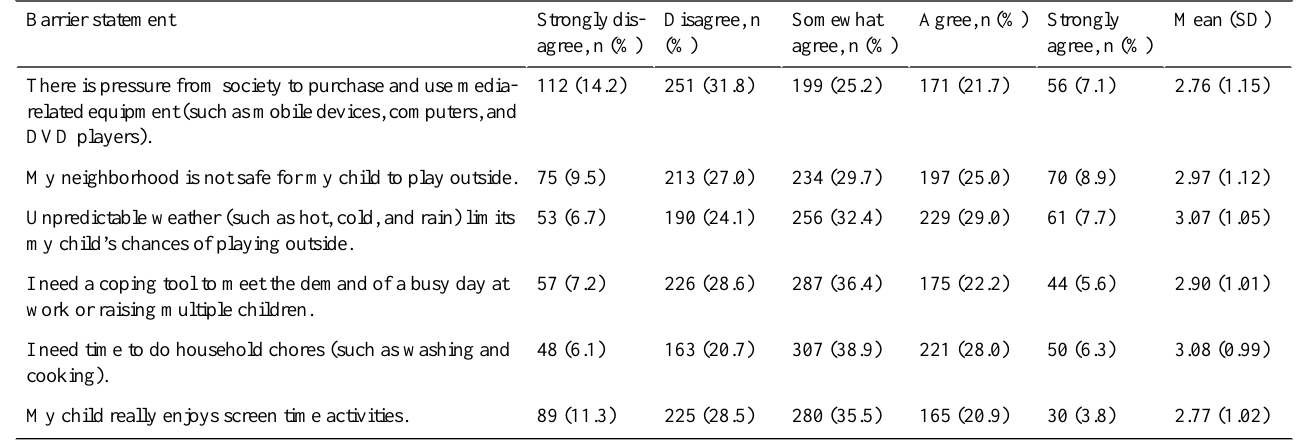
Mean (SD)Strongly (%)Agree, n (%)Somewhat (%)Disagree, n (%)Strongly dis- agree, n agree, n agree, n